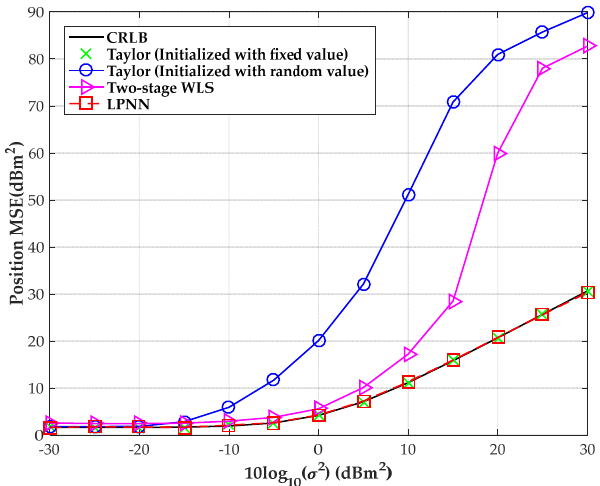
Figure 13. MSE versus level of measurement noise with the source position located at ( 300, − 280 )